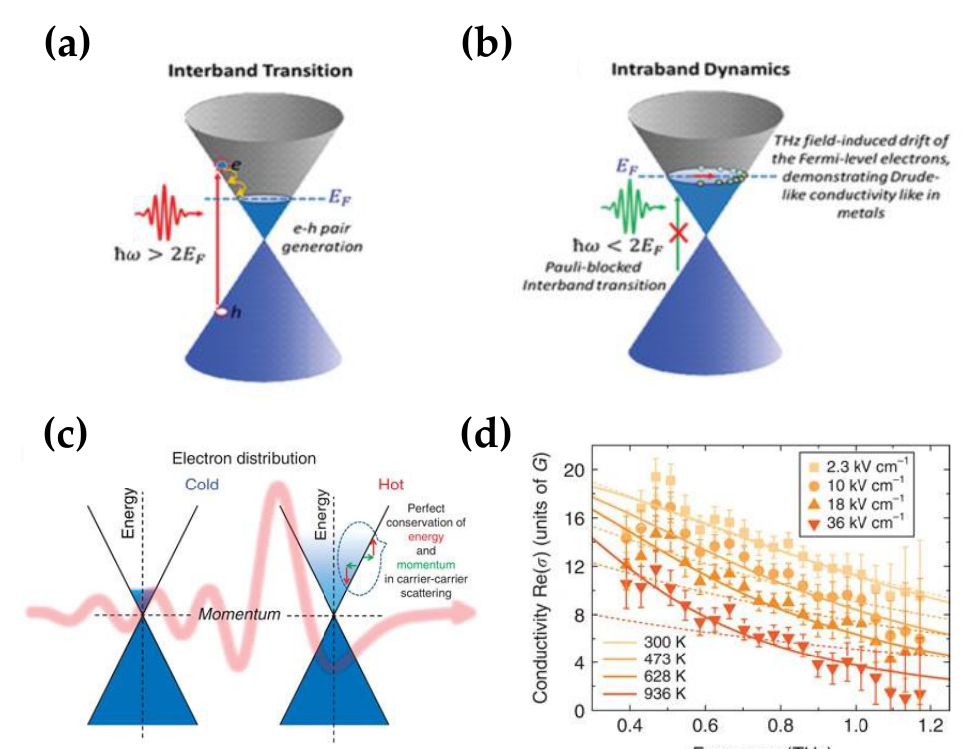
Figure 1. Interaction of graphene with the incident field. ( a ) Interband transition when the photon energy ( (cid:125) w ) is more than twice the Fermi level ( E F ); ( b ) Intraband dynamics when the incident energy ( (cid:125) w ) is lower than twice the Fermi level ( E F ); (Reprinted with permission from ref. [15]. Copyright 2020, Advanced Optical Materials) ( c ) Cold − and hot − carrier distribution in graphene, before and after incident in the THz field; ( d ) Conductivity for different carriers’ temperatures and differ- ent THz frequencies. (Reprinted with permission from ref. [50]. Copyright 2015, Nature Publishing Group)